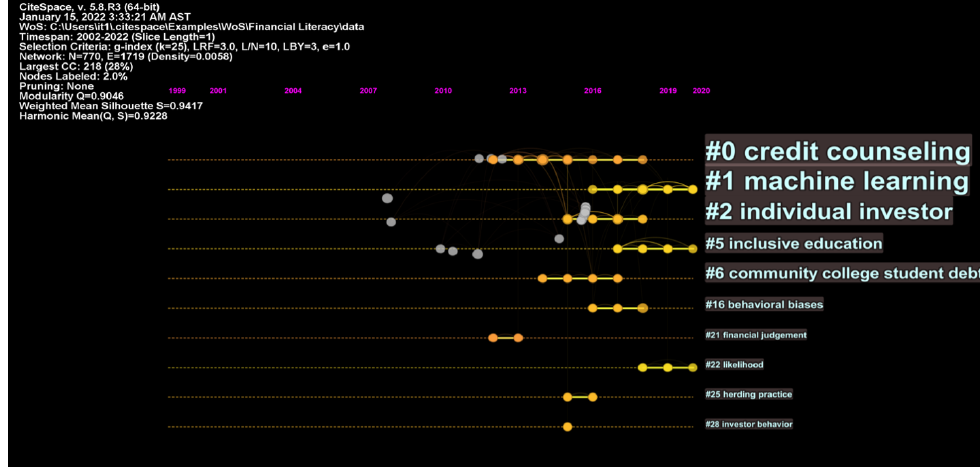
Figure 5. A timeline view of the clusters during 2001–2022 prepared using CiteSpace software.